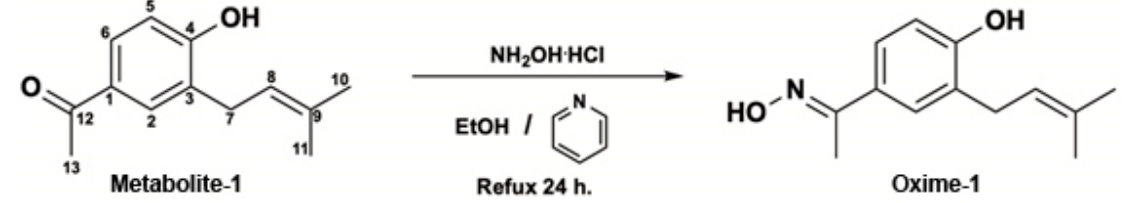
Figure 1. Structure and synthetic scheme for the preparation of new oxime 4-hydroxy-3-(isopenten-2-yl)-acetophenoxime (Oxime–1) from secondary metabolite 4-hydroxy-3-(isopenten-2-yl)-acetophenone (Metabolite–1).